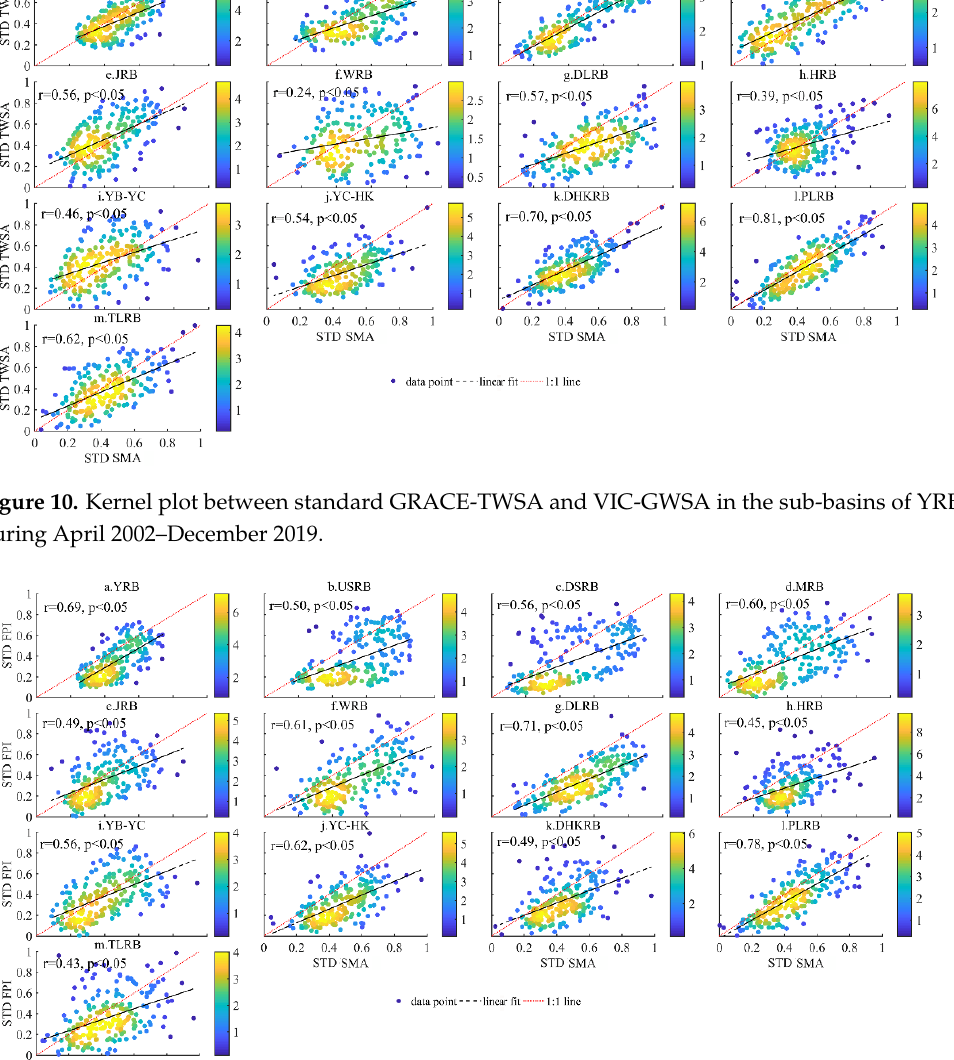
Table 2. Granger’s Causality test between VIC-SMA and GRACE-TWSA in the YRB and its sub- basins at the lags of 1–6 months.